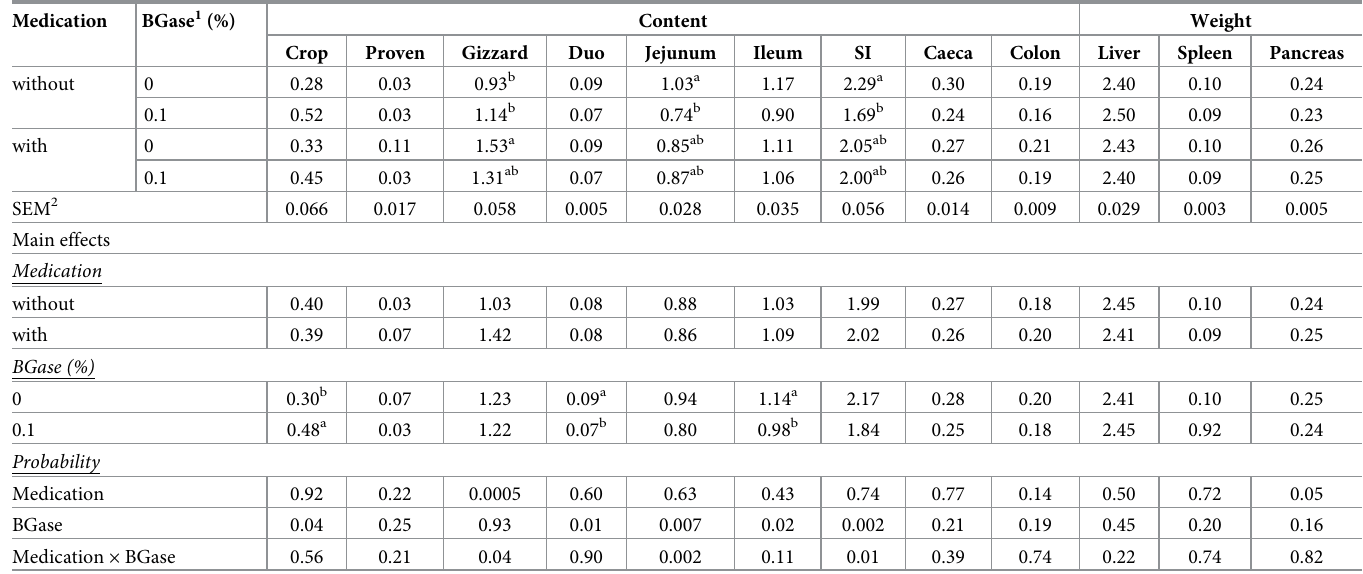
Table 8. Effects of diet medication and β -glucanase on gastro-intestinal content and organ weights as a percentage of body weight of broiler chickens at d 28 (Exper- iment 1). Medication